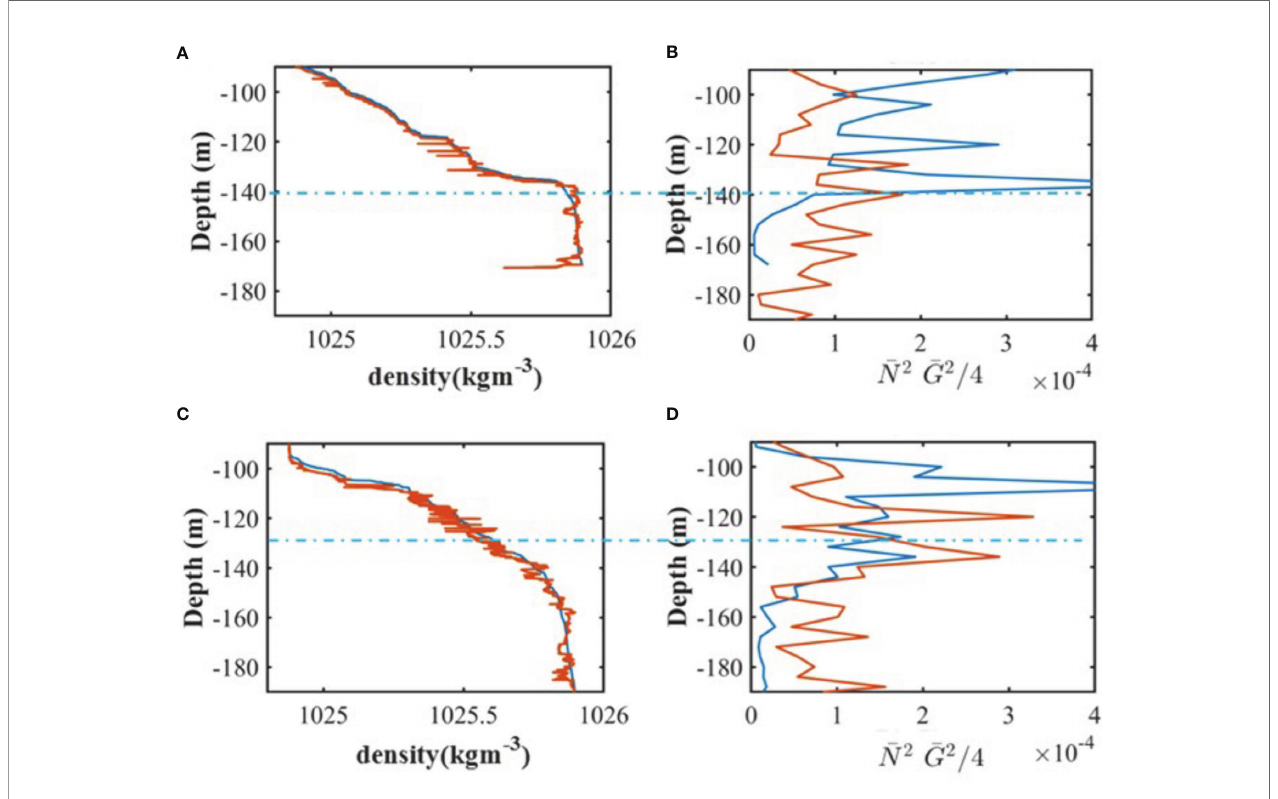
FIGURE 7 | (A) the left panel: the observed time averaged density pro fi le (red, original pro fi le) and (B) the density pro fi le reordered as a function of depth (blue, reordered pro fi le); the right panel: the time averaged fl ow shear G 2 = ( ∂ z U ) 2 + ( ∂ z V ) 2 (red) and buoyancy frequency N 2 = − g r d r The blue dash line separates the cusp-like band and the core of shear instabilities (indicated by white circles in Figure 5A ) with Ri g <0.25. (C) the left panel: the observed time averaged density pro fi le; (D) the right panel: the time averaged fl ow shear and buoyancy frequency between 03/22/2012